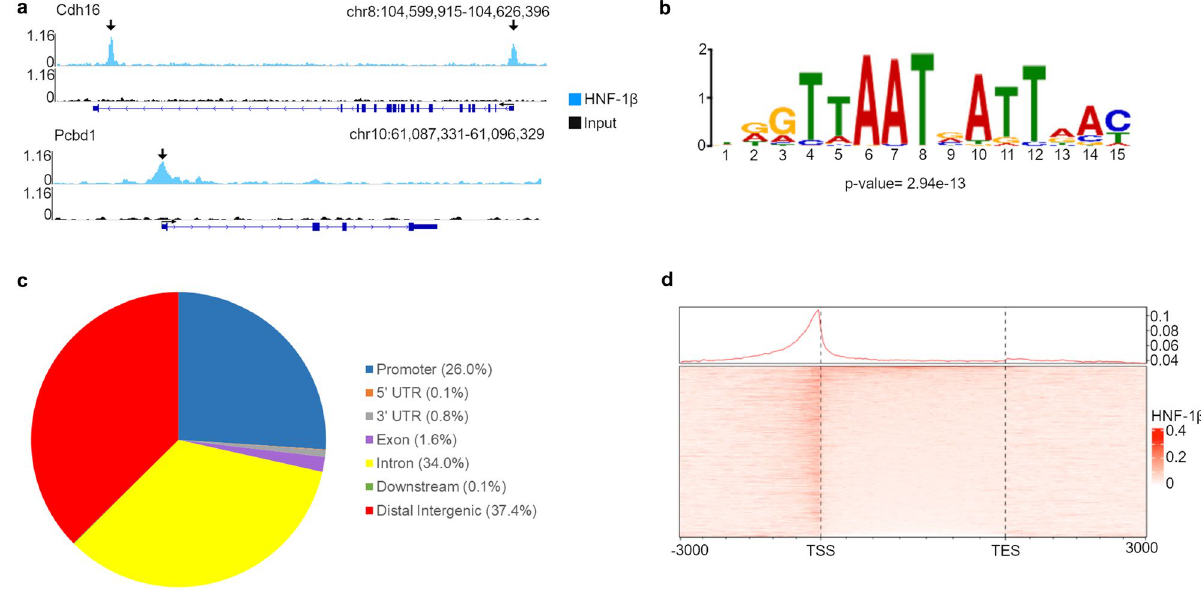
Figure 1. Identification of HNF-1β binding sites in developing mouse kidneys. ( a ) Representative ChIP-seq peaks in chromatin from E14.5 mouse kidneys. The light blue track shows the HNF-1β immunoprecipitation, and the black track shows the input sample. The gene structures are shown below (dark blue). Thin lines indicate introns, thick bars indicate exons, and arrows indicate the direction of transcription. The transcription start site is indicated by the bent arrow. Vertical arrows indicate HNF-1β binding peaks in the promoter and 17th intron of Cdh16 (upper panel) and the promoter of Pcbd1 (lower panel). ( b ) De novo motif analysis of HNF-1β binding peaks. ( c ) Pie chart summarizing the location of HNF-1β binding sites in chromatin from E14.5 mouse kidneys. The promoter region was defined as 3 kb upstream from the transcription start site (TSS), downstream was defined as < 300 bp downstream from the transcription end site (TES), and distal intergenic was defined as > 300 bp downstream of the TES or > 3 kb upstream from the TSS. ( d ) Heatmap showing HNF-1β ChIP- seq enrichment in protein-coding genes from the TSS to the TES and including 3000 bp of 5 ′ and 3 ′ flanking